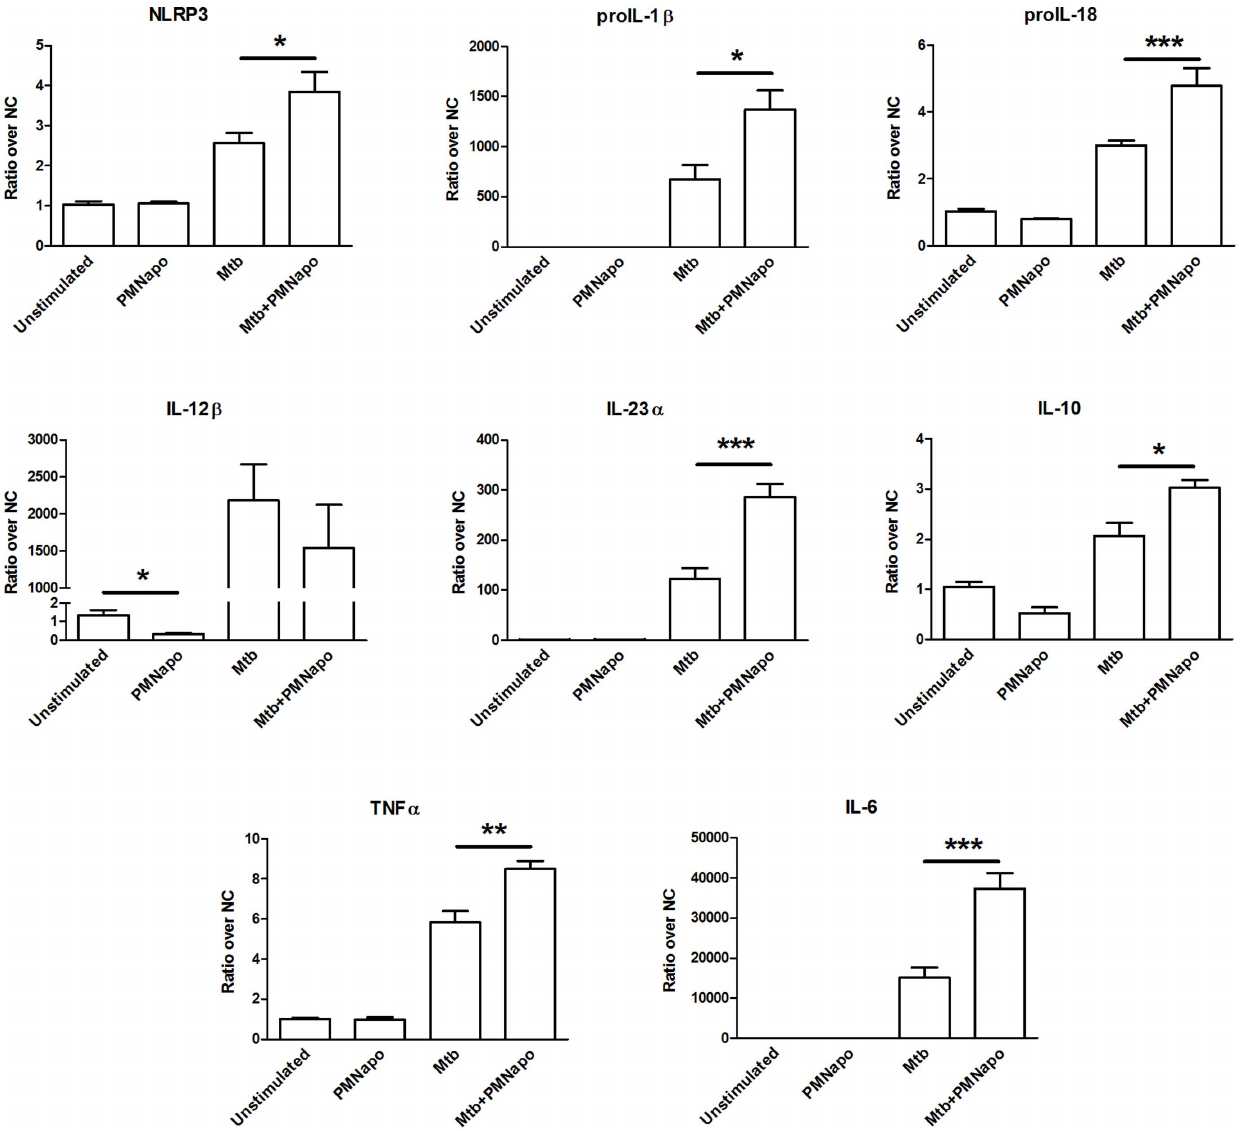
Figure 1. Apoptotic neutrophils augment the inflammatory response of macrophages to Mtb. hMDMs were stimulated with c -irr Mtb at a ratio of 5:1 (Mtb) for one hour, with or without subsequent stimulation with PMNapo at a ratio of 2:1 (Mtb + PMNapo) for one hour, where after the hMDMs were re-cultured for 20 h. hMDMs stimulated with PMNapo without prior stimulation with Mtb (PMNapo) was included as control. mRNA levels were measured by quantitative real-time PCR. Data are presented as ratios over untreated cells (NC) + SEM (n=7). Differences between groups are shown as * (p , 0.05), ** (p , 0.01) or *** (p , 0.001).